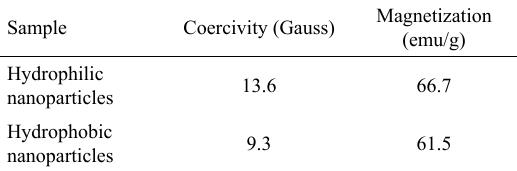
Figure 10. Hysteresis curves (A), and coercivity field values (B) of magnetic nanoparticles. Table 3: Saturation magnetization and coercivity values of the magnetic nanoparticles.